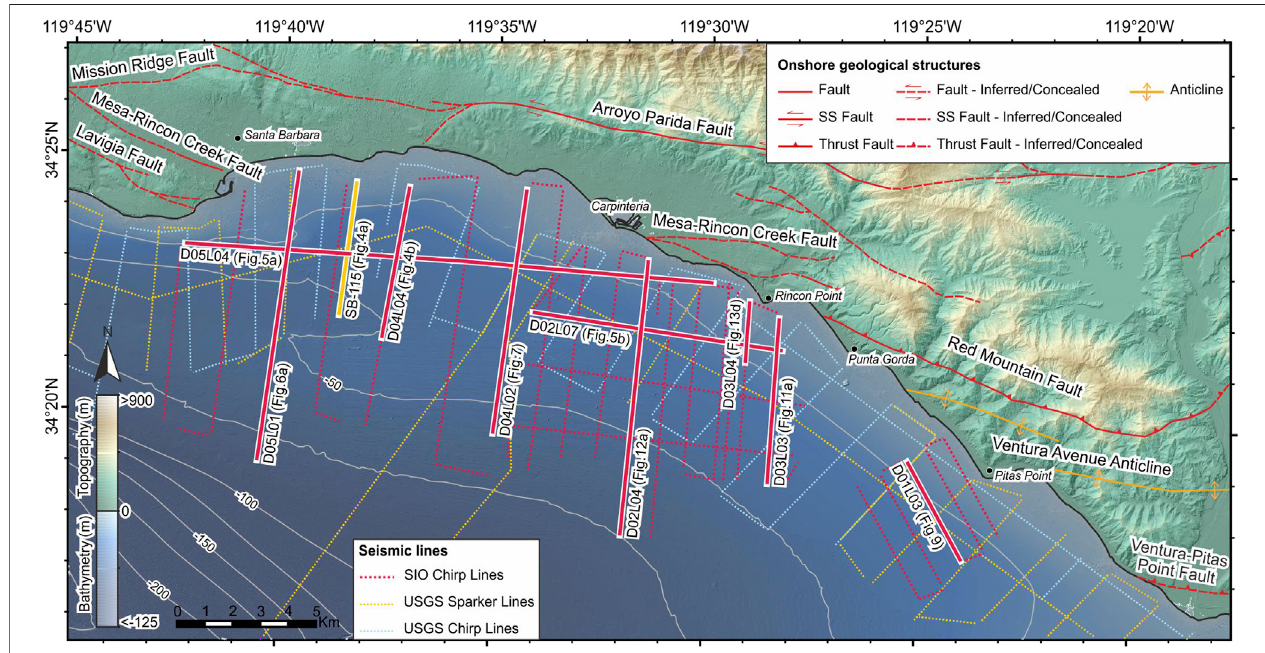
FIGURE 2 | Topographic and bathymetric map of the region between Ventura and Santa Barbara showing the location of the different high-resolution seismic re fl ectionpro fi lesusedinthisstudyandacquiredwiththeScrippsInstitutionofOceanographyCHIRPandwiththeUSGSmini-sparkerandCHIRPsystems.Thelabelled boldpro fi lescorrespondto fi guresshowninthepaper.TheactiveonshorefaultsarefromthefaultactivitymapofCalifornia(JenningsandBryant,2010).Thetopographic and bathymetric data are from the National Geophysical Data Center (2012). The location of this fi gure is shown in Figure 1 .